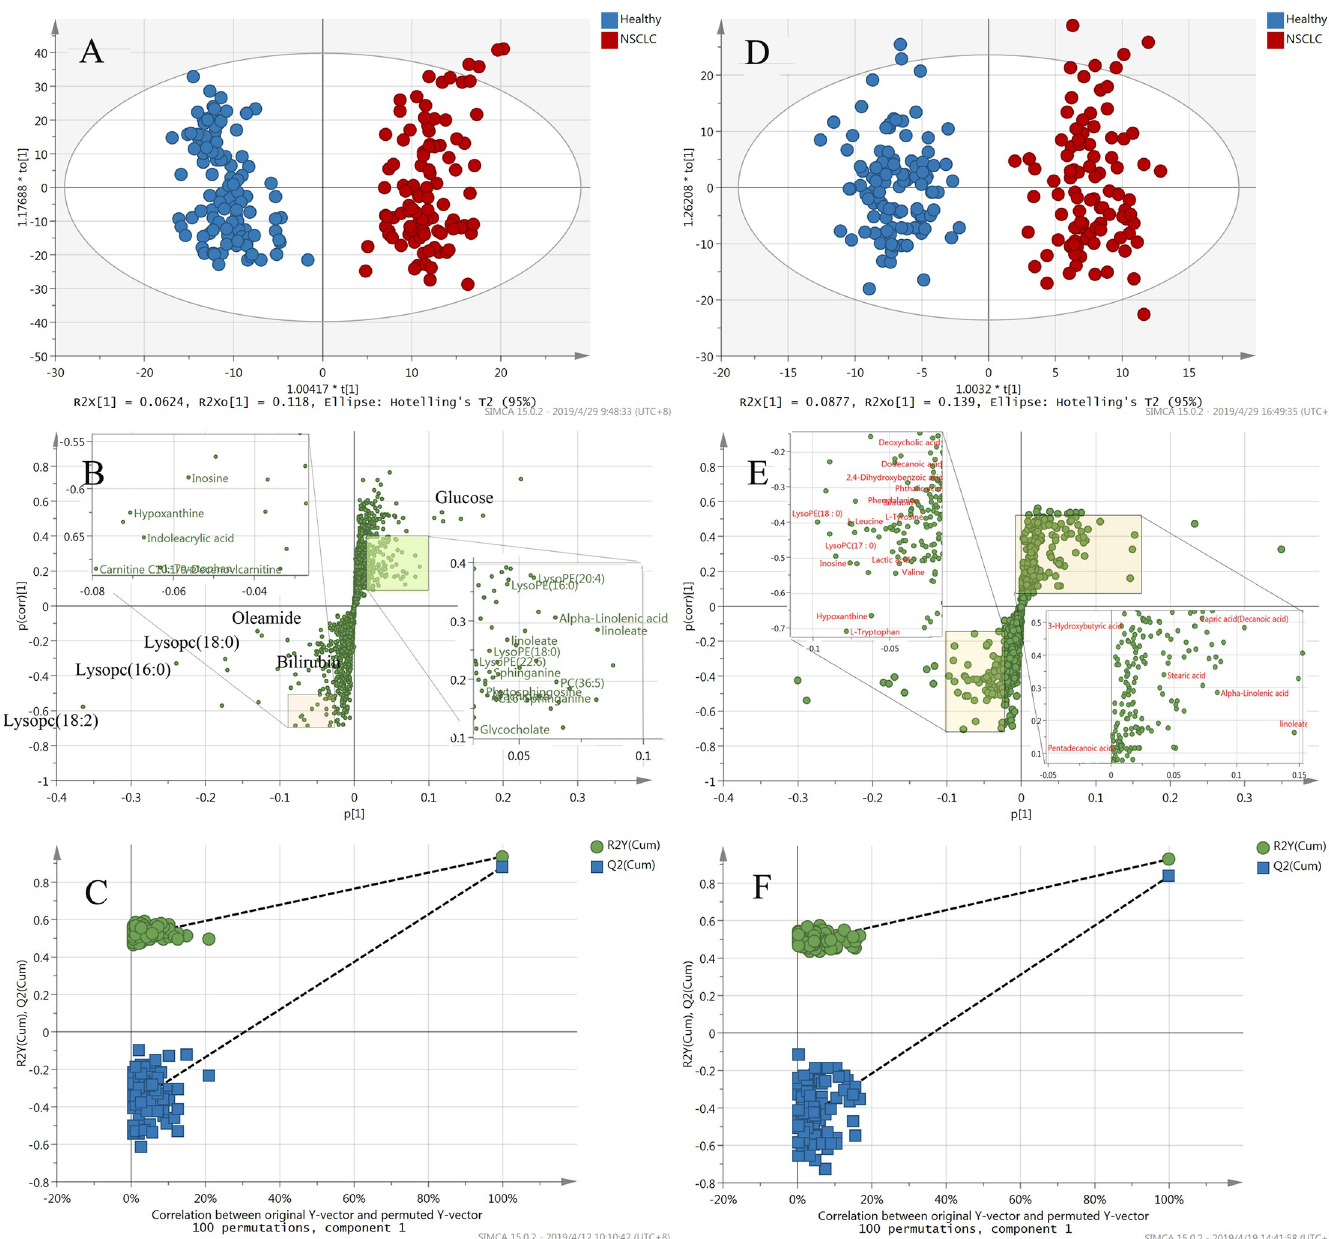
Fig 3. OPLS-DA score plots, S-plots, and validation plots for the metabolic profiling results of NSCLC patients and healthy people. (A) OPLS-DA score plot for NSCLC patients versus healthy controls in the ESI+ mode (R2X = 0.370, R2Y = 0.915, Q2 = 0.855). (B) OPLS-DA score plot for NSCLC patients versus healthy controls in the ESI- mode (R2X = 0.369, R2Y = 0.904, Q2 = 0.816). (C) S-plot for NSCLC patients versus healthy controls in the ESI+ mode. (D) S-plot for NSCLC patients versus healthy controls in the ESI- mode. (E) Permutation test for NSCLC patients versus healthy controls in the ESI+ mode. (F) Permutation test for NSCLC patients versus healthy controls in the ESI- mode. The criteria for stability and credibility are as follows: all permuted R2 and Q2 values on the left are lower than the original point on the right, and the Q2 regression line in blue has a negative intercept.